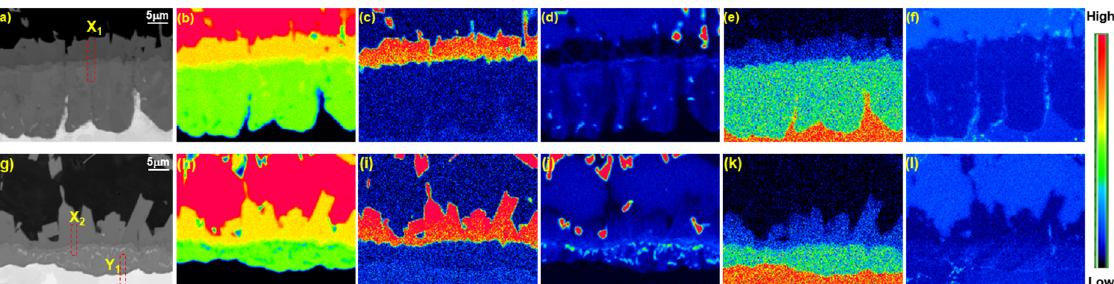
Figure 5. EPMA analysis results of reaction layers near the original steel interface in the specimens that were hot ‐ dipped at 690 °C for 120 s for Al–7Ni– x wt % Si: ( a – f ) Al–7Ni–2 wt % Si; ( g – l ) Al–7Ni–6 wt % Si; ( a , g ) BSE Image; ( b , h ) Al; ( c , i ) Ni; ( d , j ) Si; ( e , k ) Fe; ( f , l ) C.